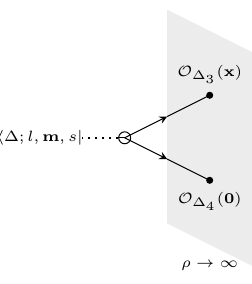
Figure 6 . Another OPE